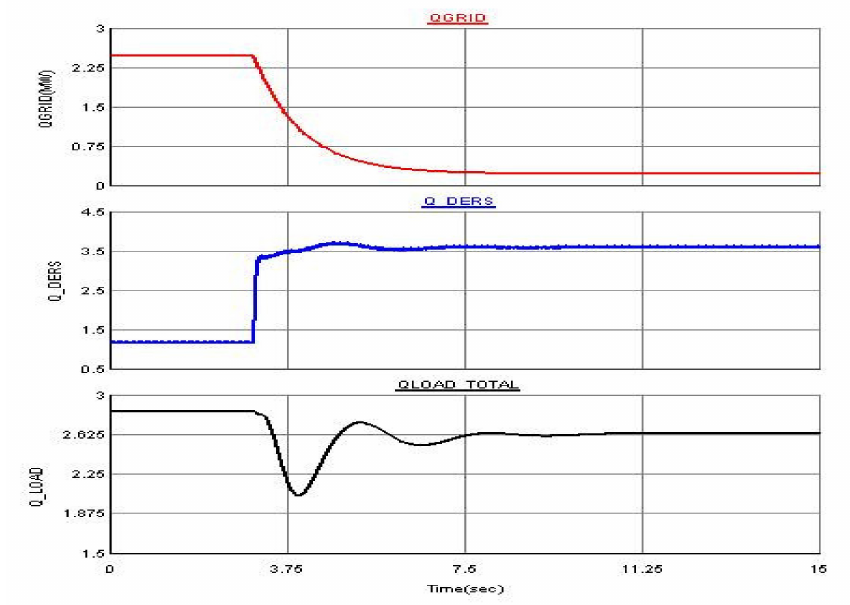
Figure 12. Grid, DERs and Load reactive